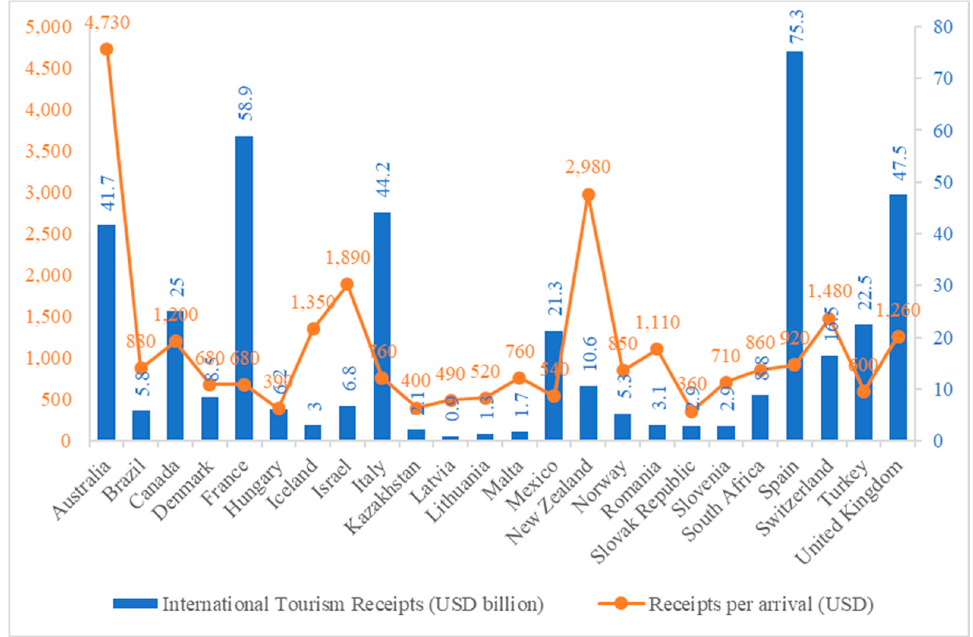
Figure 2. Total international tourism receipts, and receipts per arrival in 2017. Countries in alpha- betical order. Source: UNWTO data for 2017.